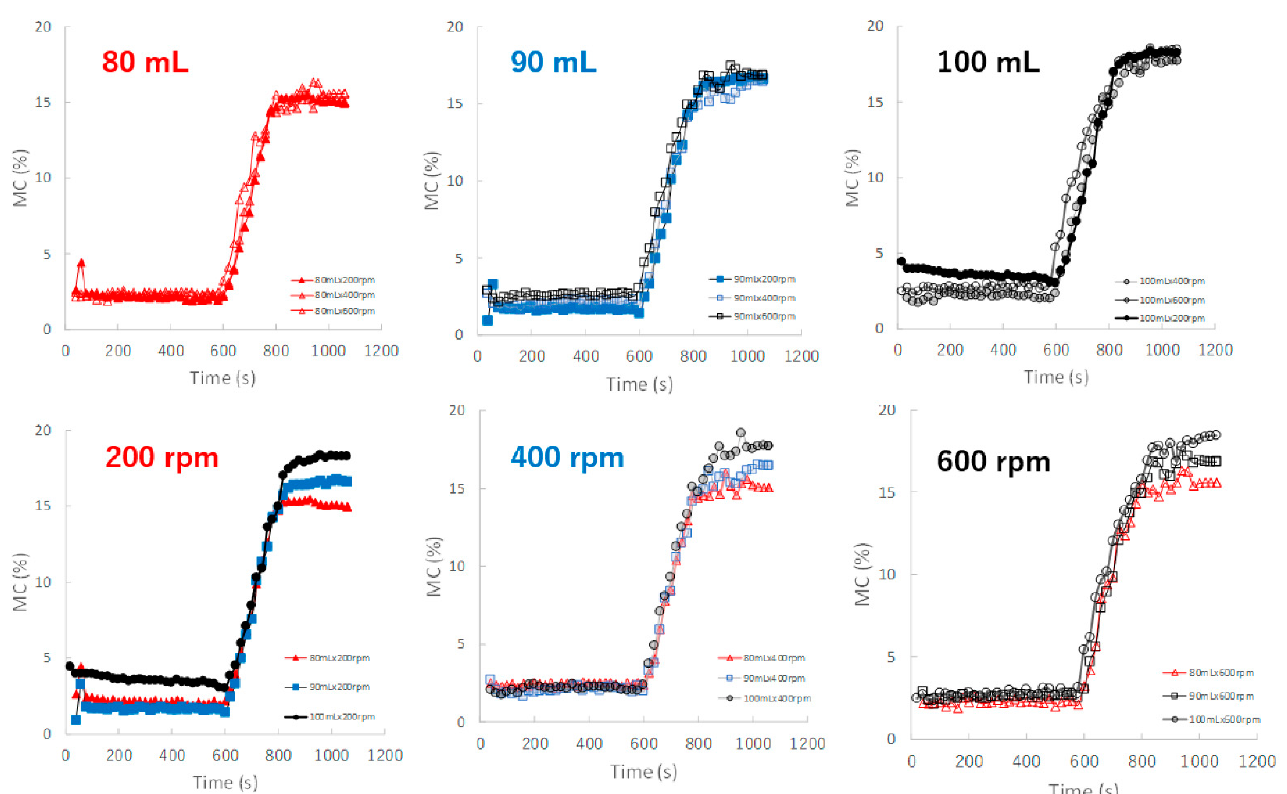
Figure 7. The effect of adding water and increasing stirring speed on real-time MC profiles of the